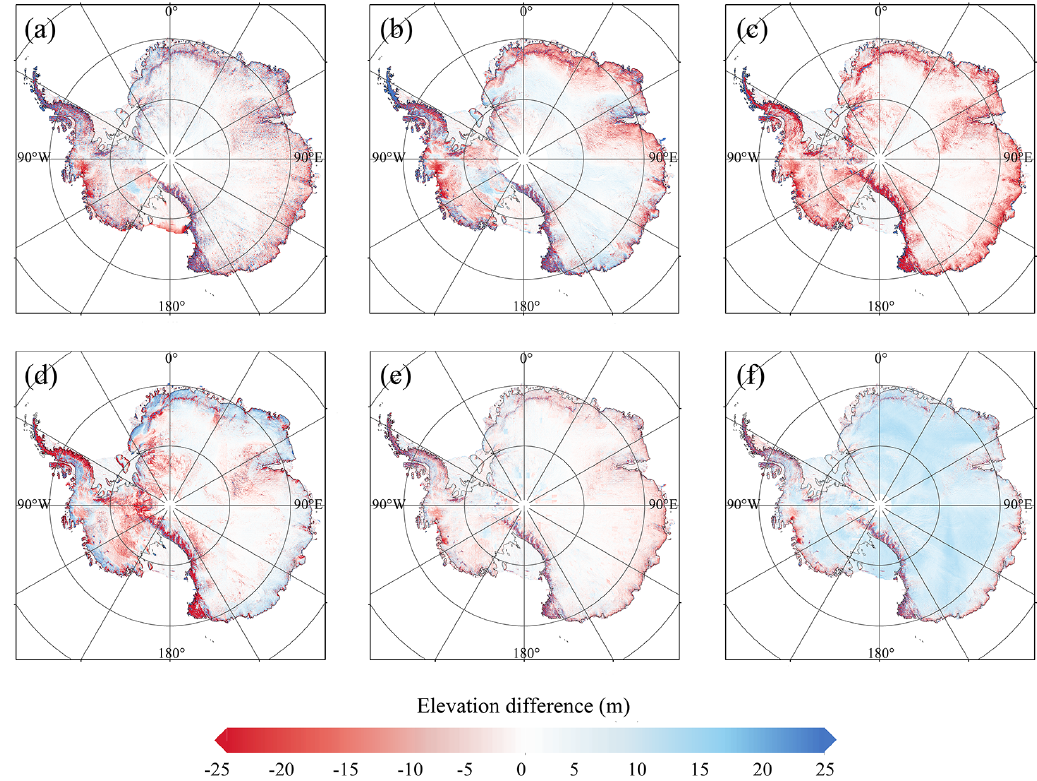
Figure 11. Elevation differences between the ICESat-2 DEM and six previously published DEMs, i.e. ICESat DEM (a) , ICESat/ERS-1 DEM (b) , Helm CryoSat-2 DEM (c) , Slater CryoSat-2 DEM (d) , REMA DEM (e) and TanDEM PolarDEM (f)